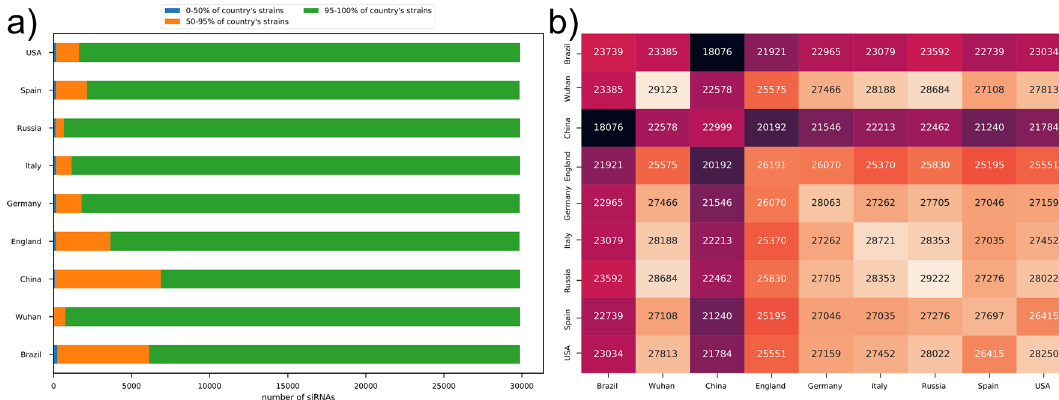
Figure 3. Coverage of 21nt siRNAs across strains from nine countries. ( a ) Targeting coverage of 21nt siRNAs across nine countries, divided in three layers: (1) 0–50% of the country’s strains; (2) 50–95% of the country’s strains; (3) 95–100% of the country’s strains. ( b ) Intersection matrix displaying the number of siRNAs with coverage higher than 95% that each country pair Figure 3a yields a big picture of country coverage for each 21nt antisense sequence siRNA. The majority of siRNAs encloses more than 95% of the strains from all countries. In spite of that, a lesser but significant portion of siRNAs encloses between 50 and 95% of the strains from all countries, with China and Brazil presenting the highest numbers (6796 and 5881 siRNAs, respectively). Russia has the smallest portion of such siRNAs (524 siRNAs). Figure 3b displays an intersection matrix from siRNAs that enclose more than 95% of the strains from each country, providing the number of siRNAs that have a match simultaneously with each country pair. Brazil